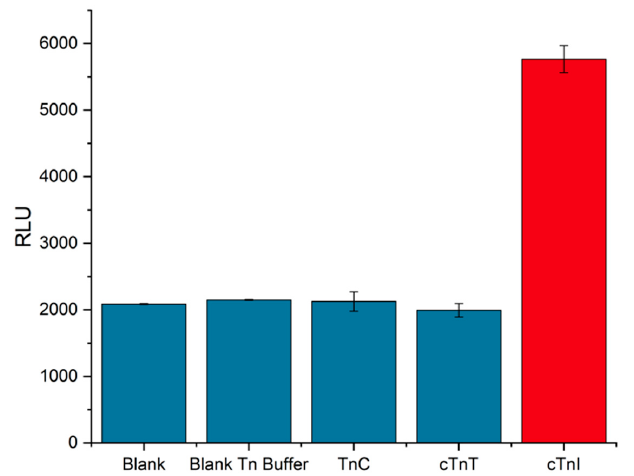
Figure 10. Antibody specificity test against cTnI: The biosensor detected cTnI (red column). No cross-reactivity with cTnT, cTnC, or any influence of the sample buffer was observed at 16 µ g/L. Chemilumi- nescence was quantified by integration of the peak area. Error bars represent one standard